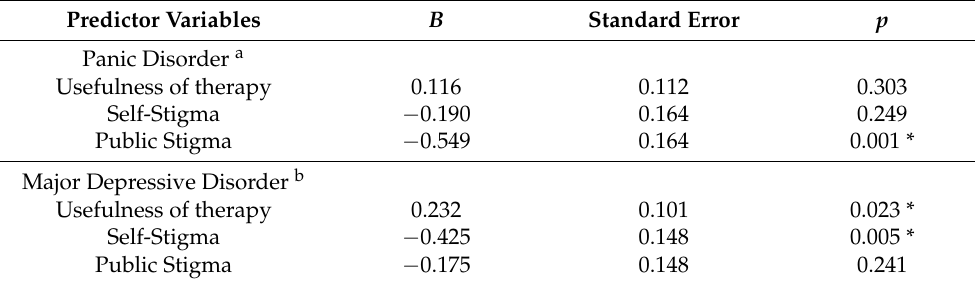
Table 1. Linear regression analysis results for predictors of perceived likelihood to seek therapy with Panic Disorder and Major Depressive Disorder. Predictor Variables B Standard Error p Panic Disorder a Usefulness of therapy 0.116